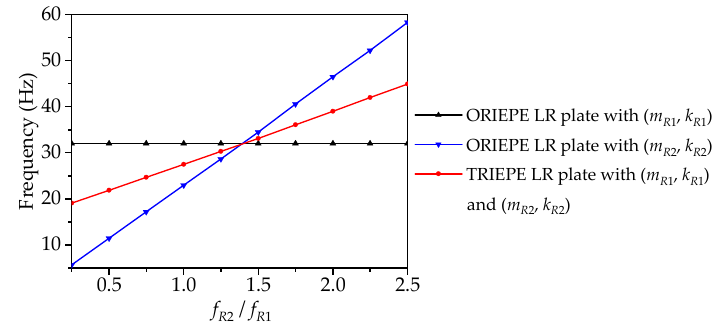
Figure 4. The total bandwidths of the band gaps in the three locally resonant plates in Figure